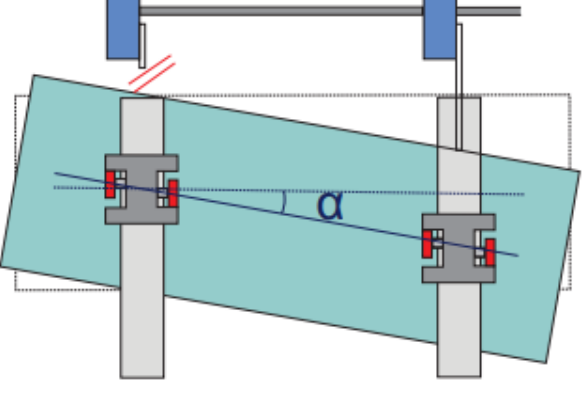
Figure 1. Schematic representation of flap warping [6].